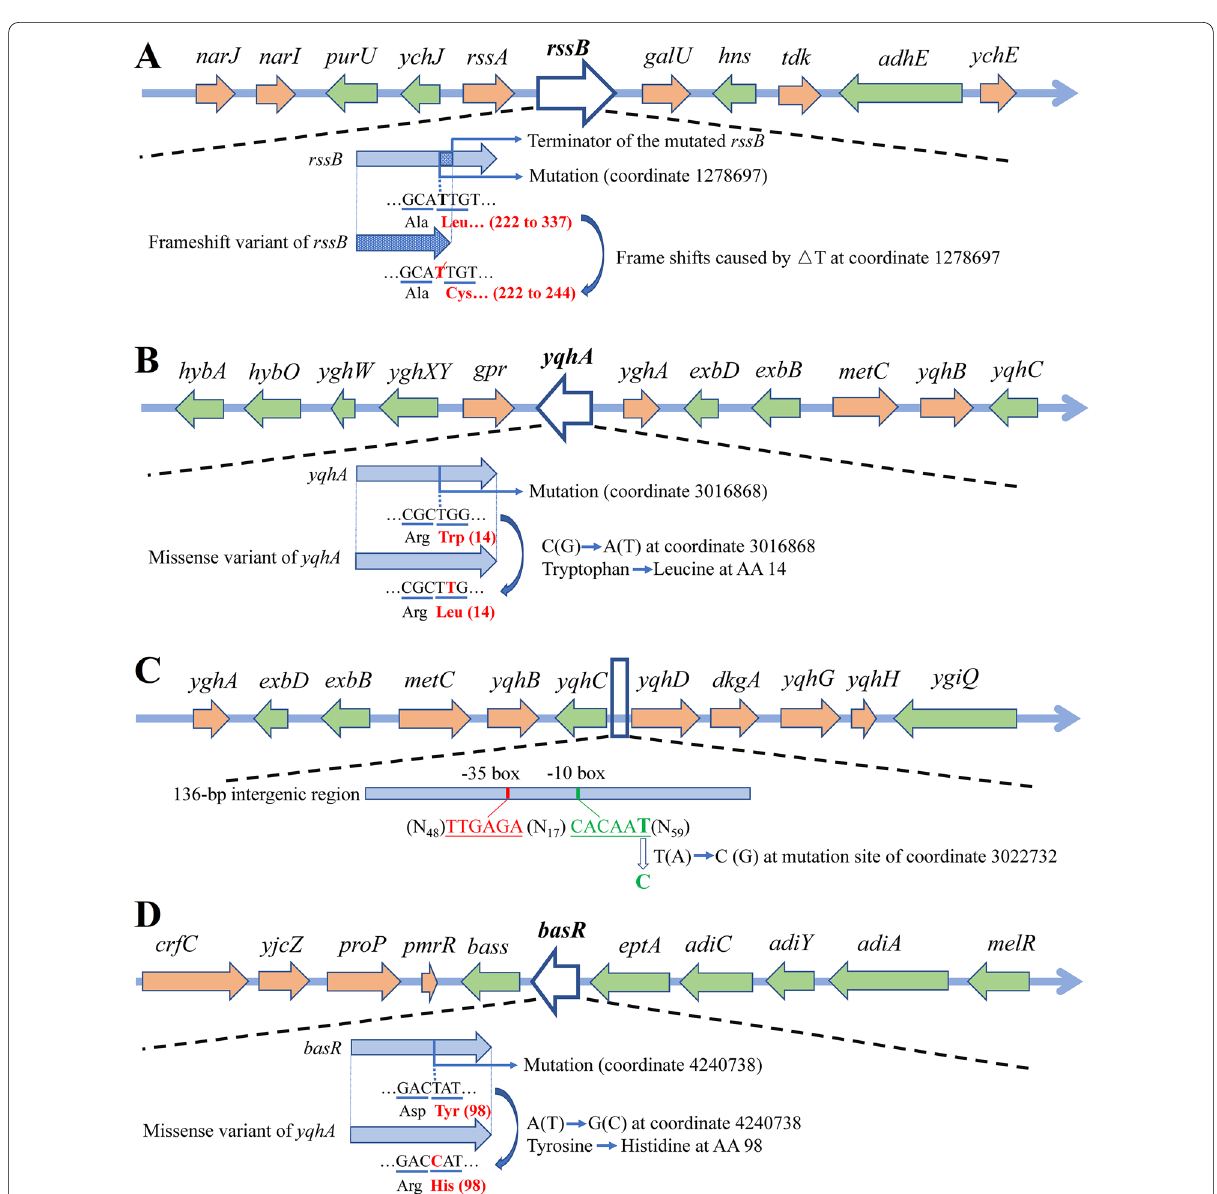
Fig. 3 The mutations and mutation effects on gene expression/regulation. The surrounding genes annotated as upstream or downstream gene variant type by whole-genome sequencing are also shown here, with their directions on the genome. Mutation in rssB ( A ) caused the translational stop codon (TGA) to move forward, with a deletion of a total of 93 amino acids from the 245th position of RssB. Mutations in yqhA ( B ), intergenic region of yqhC - yqhD ( C ), and basR ( D ) resulted in missense variants. △ denotes deletion, and AA denotes amino